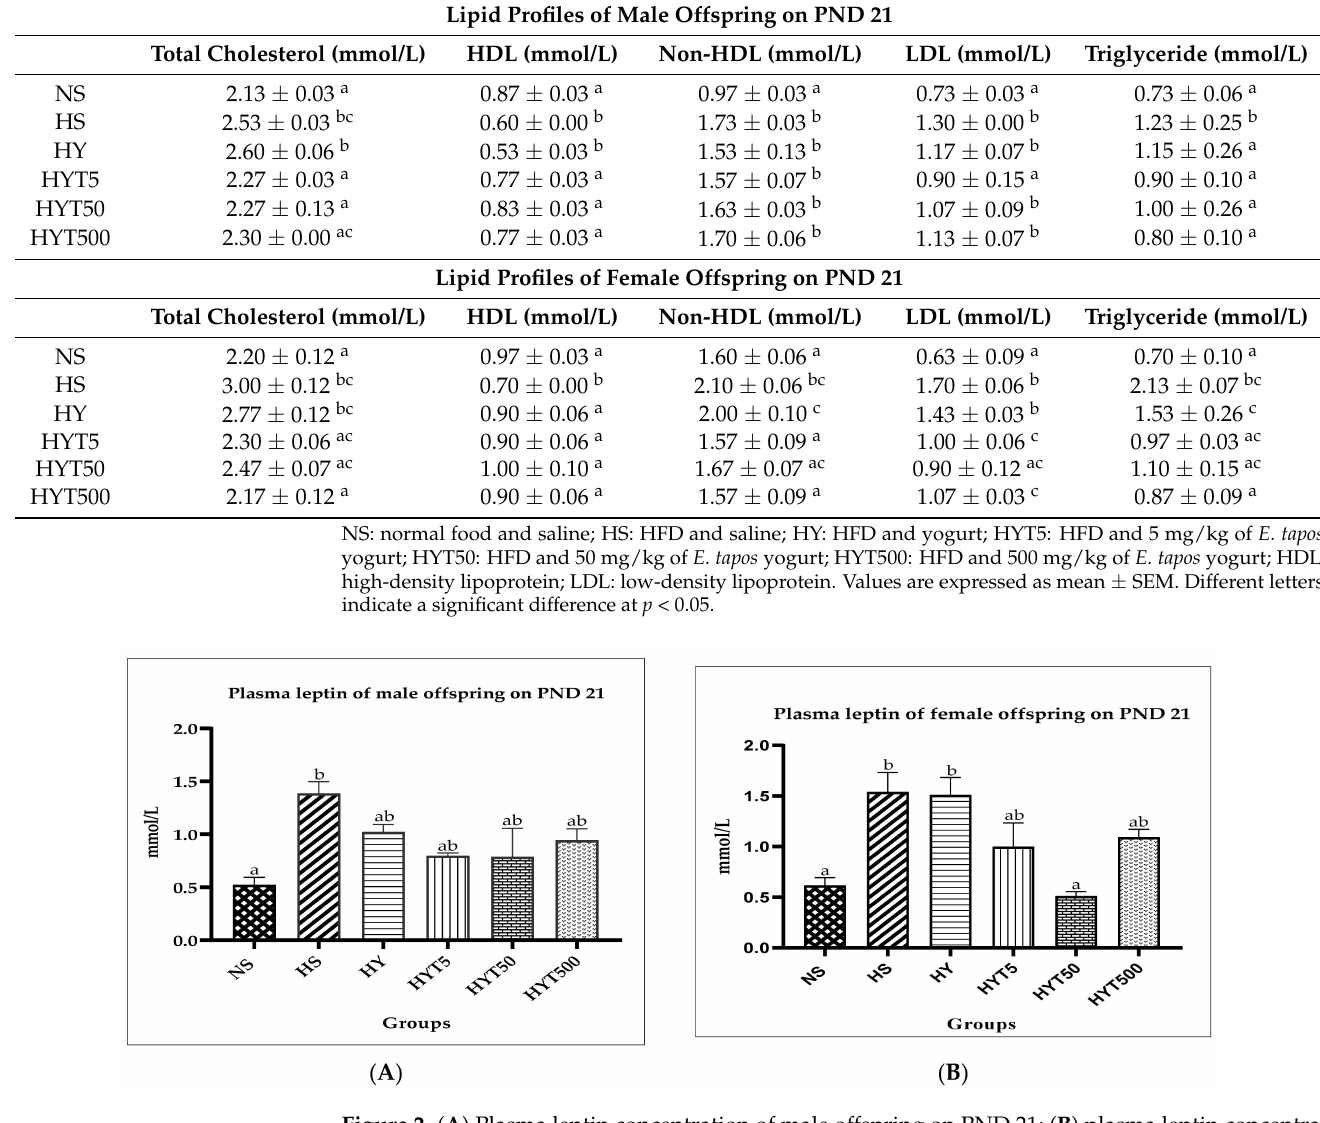
Figure 2. ( A ) Plasma leptin concentration of male offspring on PND 21; ( B ) plasma leptin concentra- tion of female offspring on PND 21. NS: normal food and saline; HS: HFD and saline; HY: HFD and yogurt; HYT5: HFD and 5 mg/kg of E. tapos yogurt; HYT50: HFD and 50 mg/kg of E. tapos yogurt; HYT500: HFD and 500 mg/kg of E. tapos yogurt. Different letters indicate a significant difference at p <